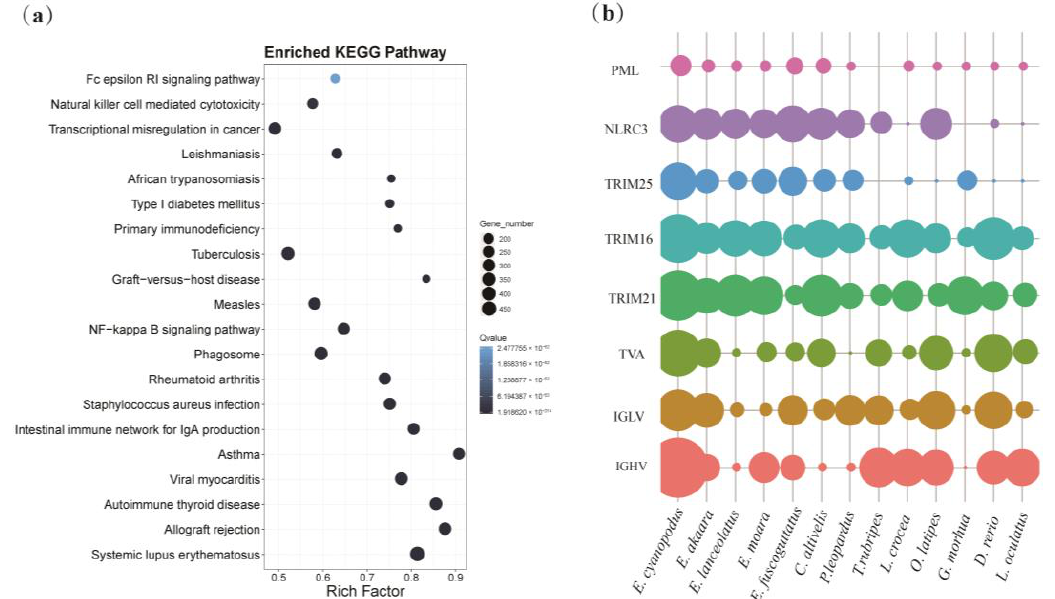
Figure 4. Visualization of expanded gene families in E. cyanopodus : ( a ) the top 20 significant enriched KEGG terms for expanded gene families in E. cyanopodus genome; and ( b ) the most significant expanded gene families in E. cyanopodus ; the size of spots displays the number of genes.